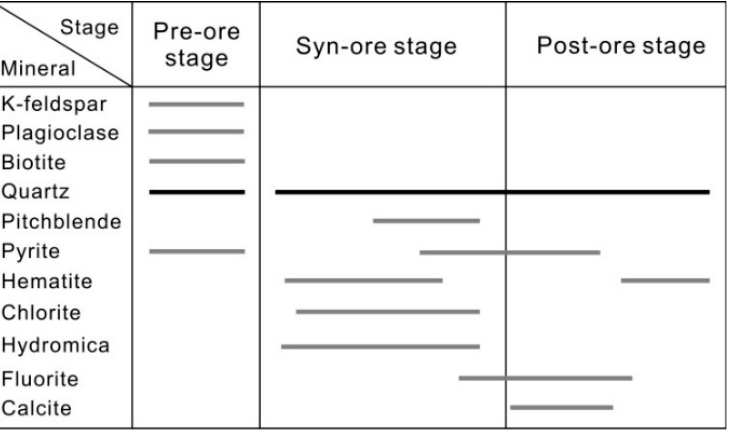
Figure 4. Simplified paragenesis of major mineralization and gangue minerals in the Mianhuakeng uranium deposit.